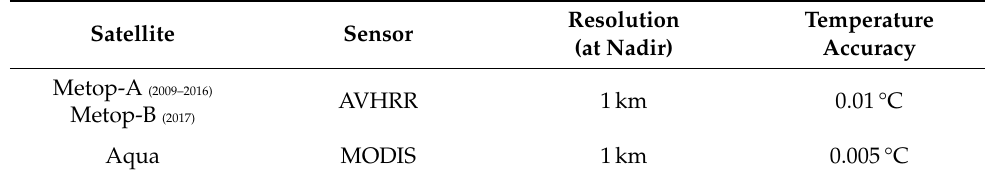
Table 1. Satellite data